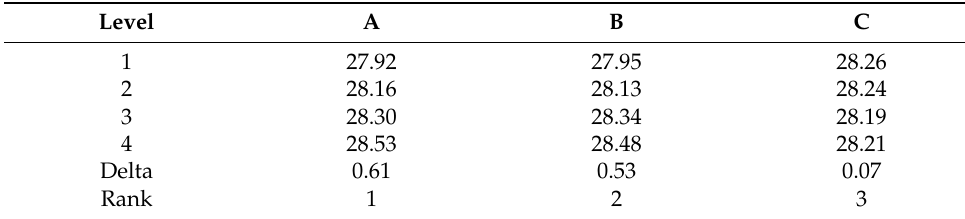
Table 6. Parameter ranking for S/N ratios of peak load.